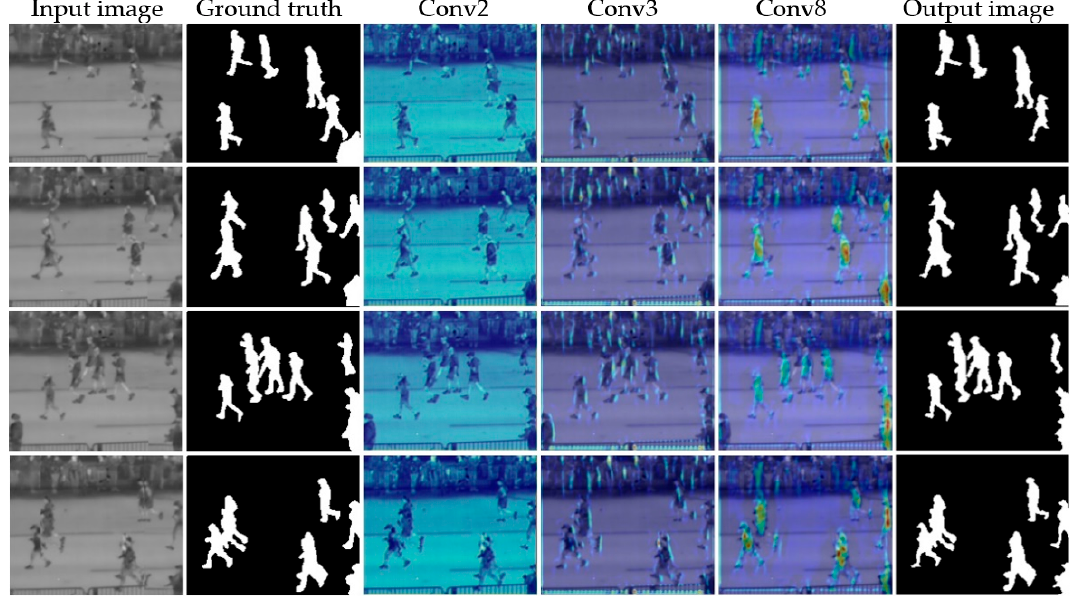
Figure 23. Example images extracted from Mask R-CNN layers by using